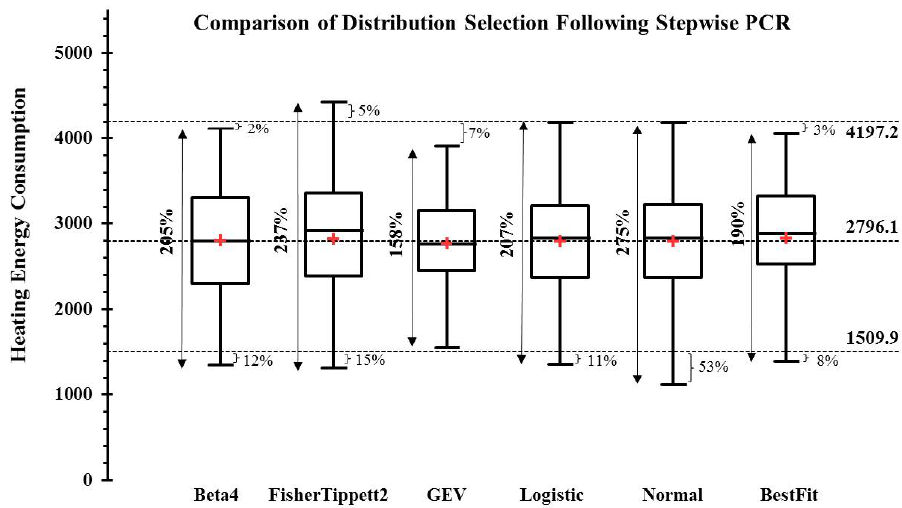
Figure 9. Heating energy use probability density functions when following a Stepwise Principal Component Regression model and comparing selection of various input principal component distribution series used in the uncertainty propagation